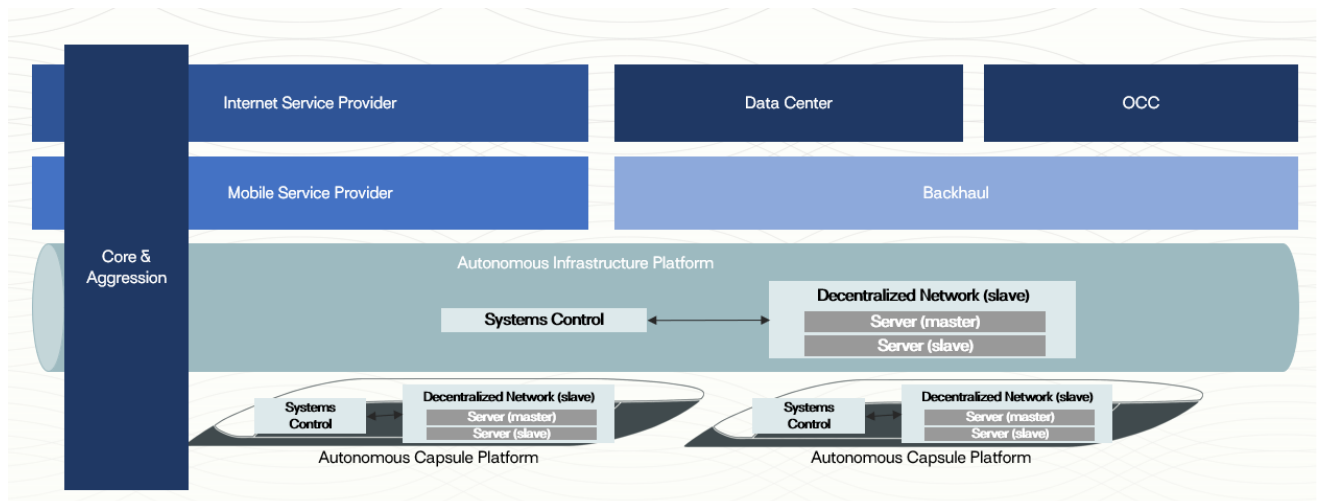
Figure 2. Hyperloop TT connected